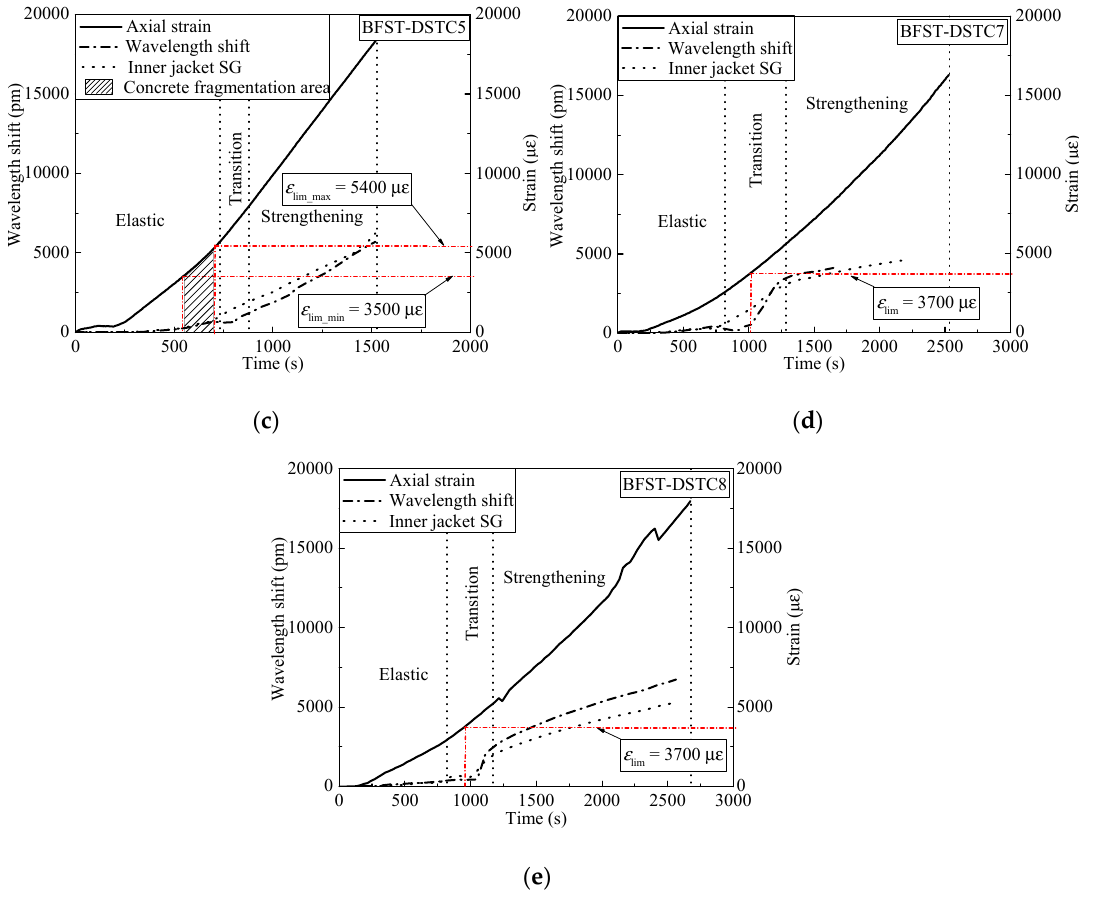
Figure 11. Axial strain monitoring based on the inner tube WS for specimens: ( a ) BFST-DSTC2; ( b ) BFST-DSTC3; ( c ) BFST-DSTC5; ( d ) BFST-DSTC7; ( e ) BFST-DSTC8.